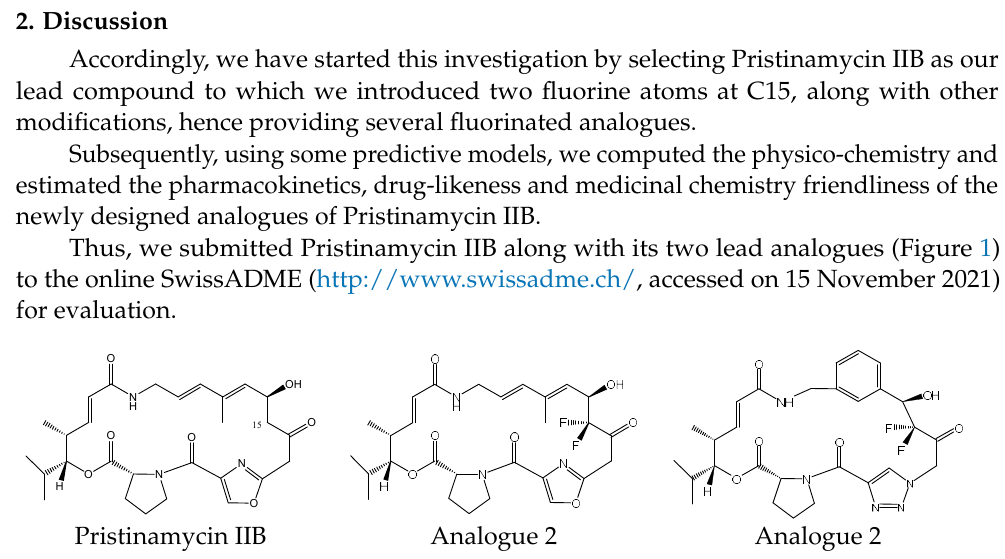
Figure 1. Pristinamycin IIB with its two newly designed lead analogues.